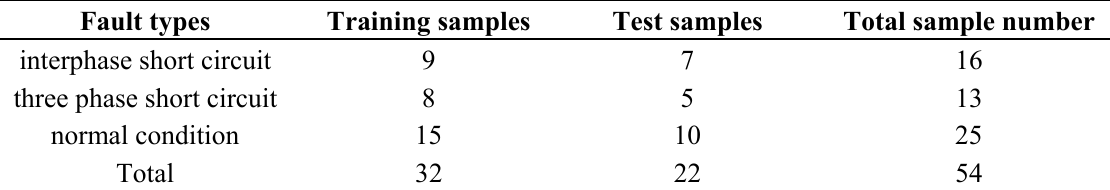
Table 1. Cable fault sample